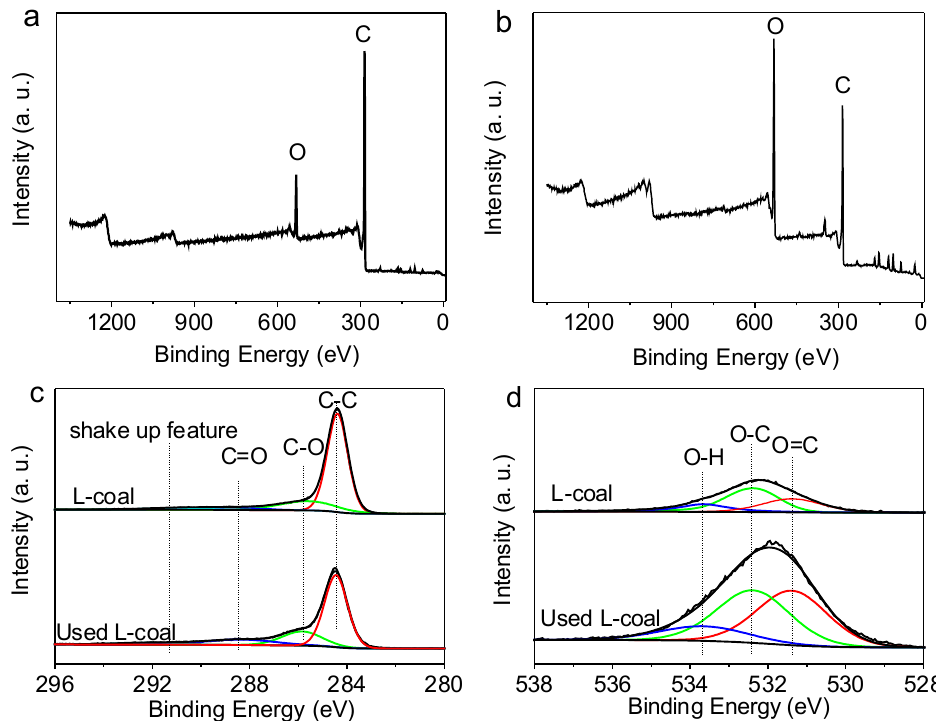
Figure 6. XPS spectra of ( a ) L-coal powder and ( b ) used L-coal powder, ( c ) C 1s core-level spectrum and ( d ) O 1s core-level spectrum of L-coal powder and used L-coal powder.